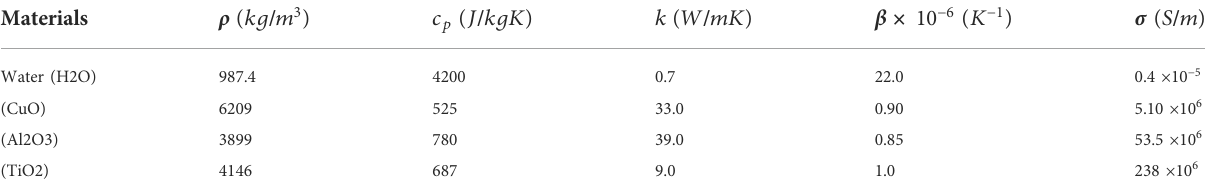
TABLE 3 Thermo physical properties water and nanoparticles (Jamshed and Aziz, 2018; Jamshed, 2021; Khashi ’ ie et al., 2020). Materials